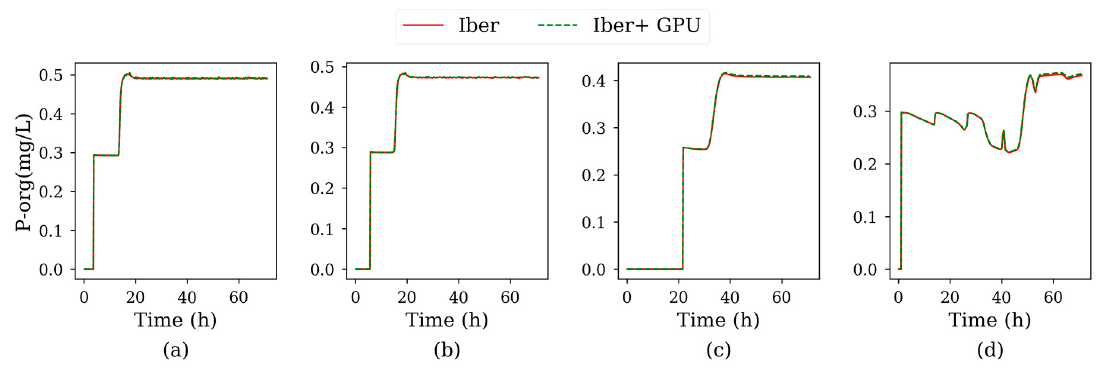
Figure A10. Time series of organic phosphorus for Test 4, sampled at control points P1 ( a ), P2 ( b ), P3 ( c ) and P4 ( d ).